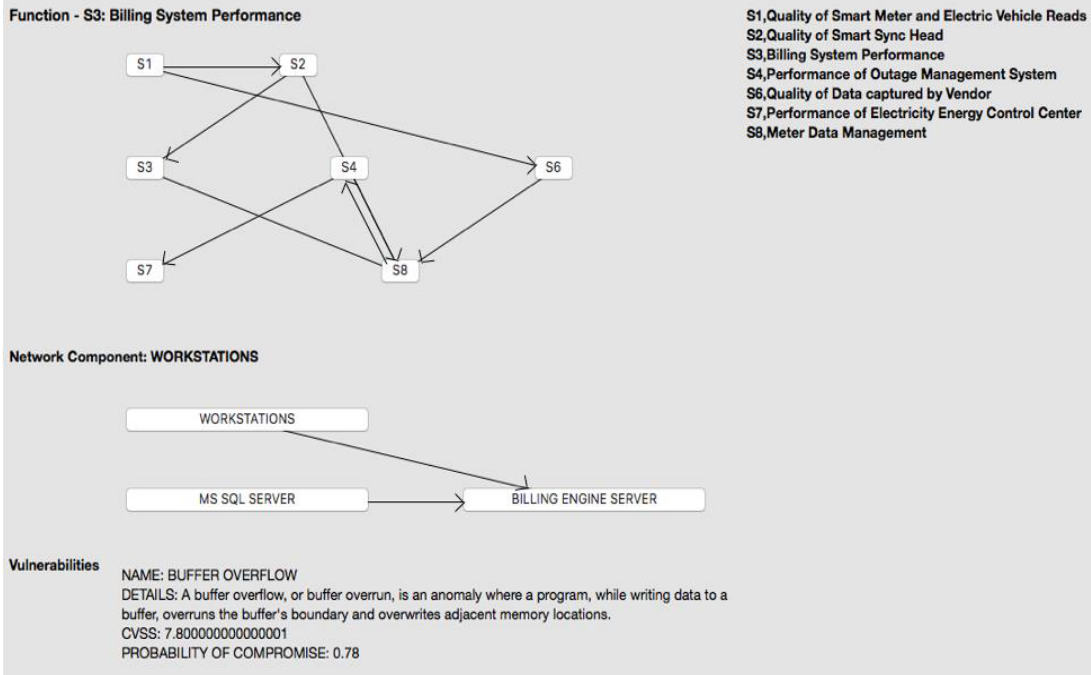
Figure 6. Function (top), network (middle) and vulnerability (bottom) Bayesian network. CVSS, Common Vulnerability Scanning Score.